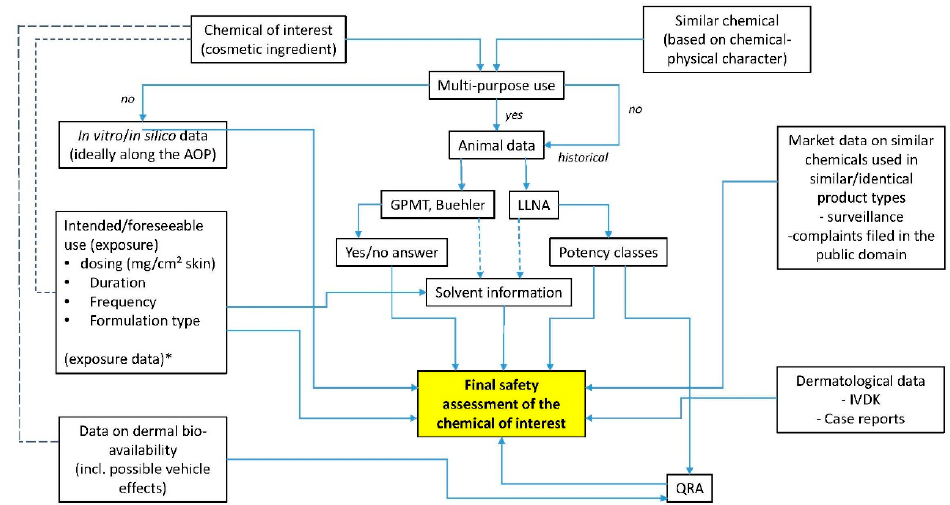
Figure 2. Complexity of data sourcing for a proper safety assessment on skin sensitization in the context of the current animal testing ban.